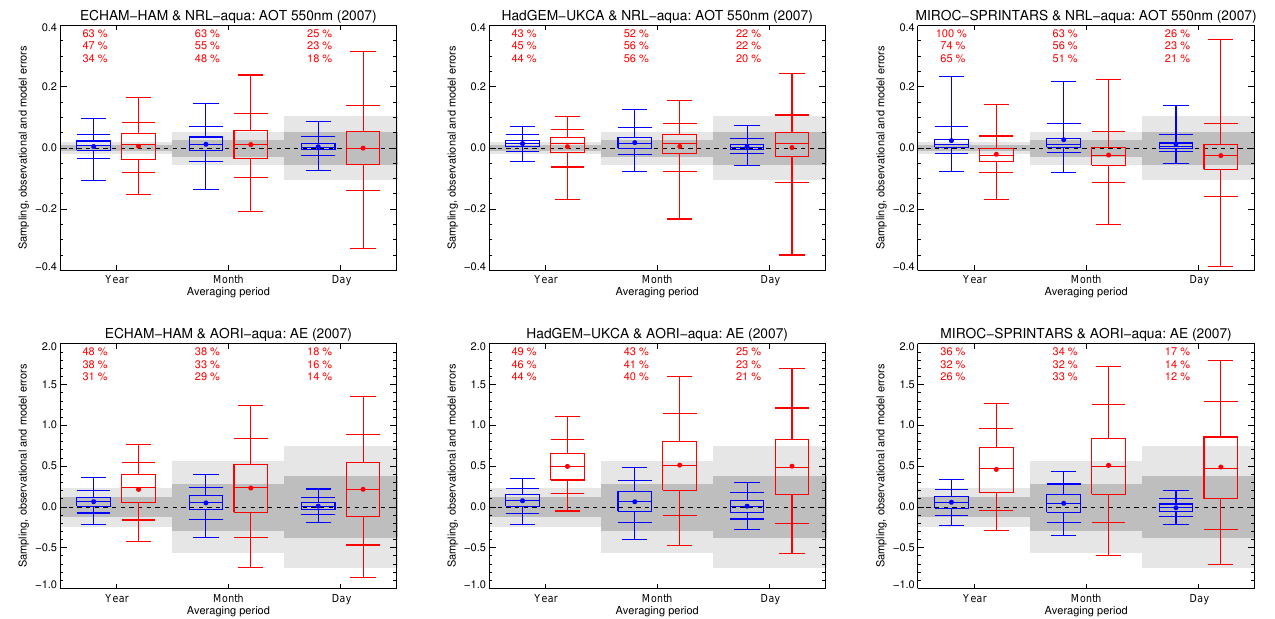
Figure 12. Box-whisker plots of temporal sampling errors, observational and model errors. For MODIS Aqua, sampling errors (blue), observational errors (grey) and model errors (red) are shown side by side as a function of averaging period (yearly, monthly, daily). The box-whisker plot shows the 2, 9, 25, 50, 75, 91 and 98% quantiles of these errors, the dot shows the mean error. The grey shading shows the 9, 25, 75 and 91% quantiles of the observational errors. The red numbers above each blue box-whisker show how the different quantile ranges (from top to bottom: 2–98, 9–91 and 25–75%) compare between the sampling error and the model errors.